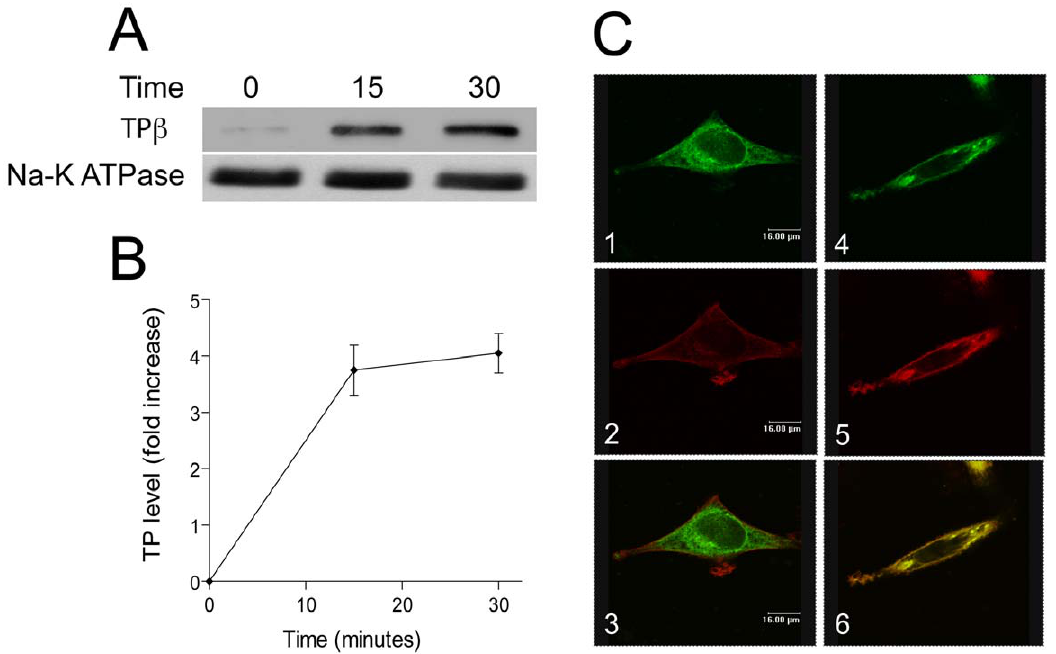
Figure 2. Effects of hydrogen peroxide on surface expression of endogenously expressed TP in PC3 prostate carcinoma cells. Panel A: TP b detection on the surface of PC3 cells. Endogenous TP b was labeled using a water-soluble biotin analogue and recovered with streptavidin beads at the cell surface following challenge with 10 m M hydrogen peroxide. Streptavidin-bound proteins were analysed by immunoblotting. Panel B: Quantitation of delivery of TP b to the cell surface from two separate experiments, demonstrating rapid increase of streptavidin-accessible molecules. Panel C: Confocal imaging of TP translocation to the cell surface. Panels 1 to 3 are resting cells and 4 to 6 following hydrogen peroxide challenge at 40 minutes. Panels 1 and 4 are stained for TP, 2 and 5 for TRITC-phalloidin to visualize cortical actin, and 3 and 6, are merged images. Scale bar is 16 m m.